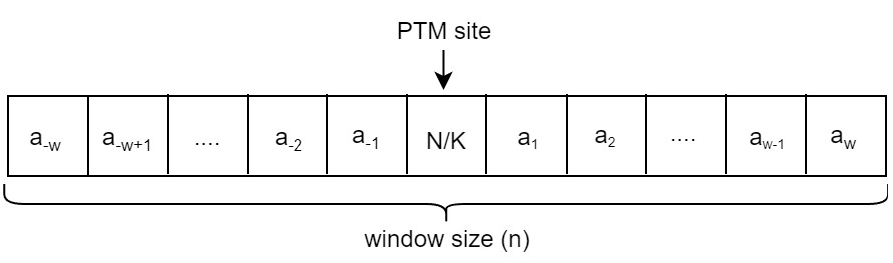
Figure 2. Window size of sample sequence. The size of the window is n = 2 ∗ w + 1 in which w residues surrounding the PTM site from both left and right sides.